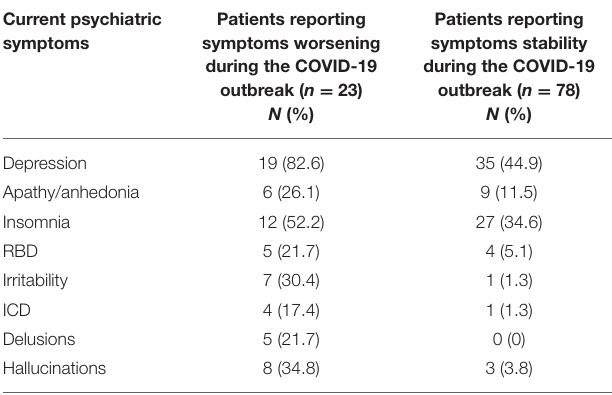
TABLE 1 | Current psychiatric symptomatology in patients reporting symptoms worsening or stability during the COVID-19 outbreak. Current psychiatric Patients reporting symptoms symptoms